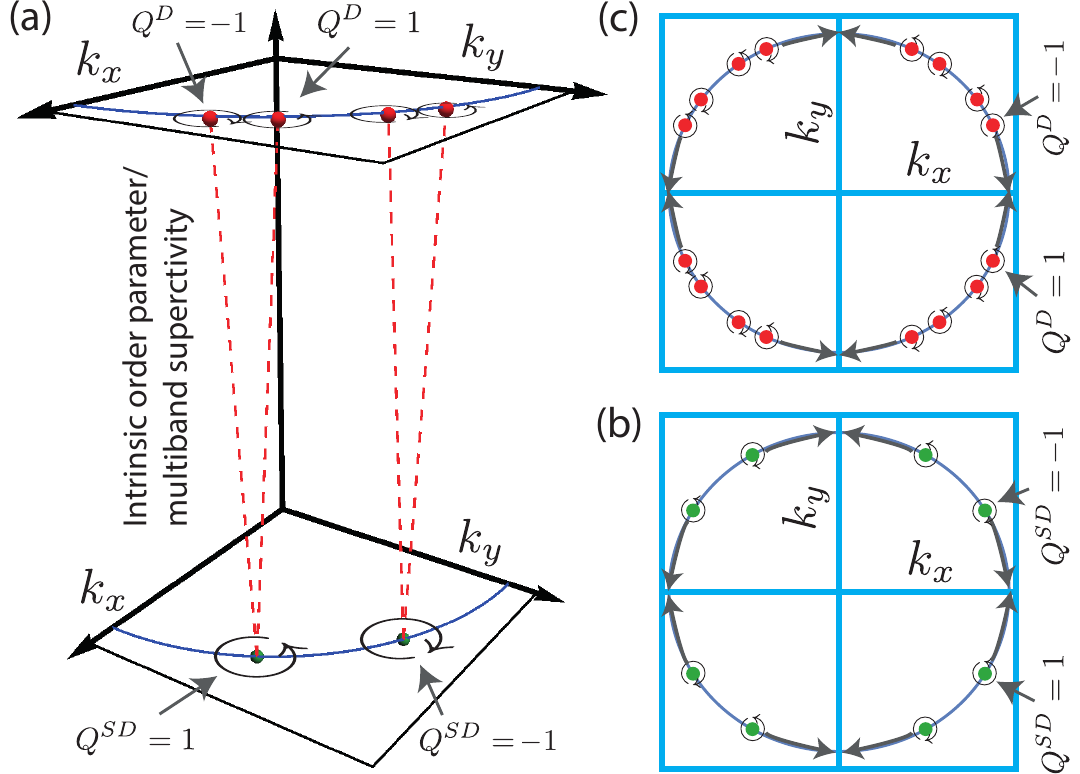
Figure 3: Different types of topological phase transitions occurring in heterostructures where Sr IrO is tunnel coupled to a t -ES. (a) Lower plane: a pair of semi-Dirac points carrying 2 4 2 g topological charges Q SD = ± 1. They are protected against small perturbations in the presence of symmetries of the model, metallic t -ES and a single active band in Sr IrO . Upper plane: 2 g 2 4 Each semi-Dirac point can become gapped or split into two Dirac points with opposite topo- logical charges Q D = ± 1 if these conditions are intentionally broken so that the t metal is 2 g coupled to two different layers of Sr IrO (effectively a multiband superconductor) or the t - 2 4 2 g ES supports an intrinsic superconducting order parameter. These transitions are described by Hamiltonian (3). (b) In the constrained parameter space, where the semi-Dirac points are sta- ble against small perturbations, two semi-Dirac points with opposite topological charges Q SD can be nucleated or annihilated in a pairwise manner. These merging transitions are desribed by Hamiltonian (6). (c) In the unconstrained parameter space, where a semi-Dirac point can split into two Dirac points, the Dirac points can move in the momentum space and merge with Dirac points (carrying opposite Q D ) that have emerged from other semi-Dirac points. When this merging occurs at the mirror lines (thick blue lines) these transitions lead to topological mirror